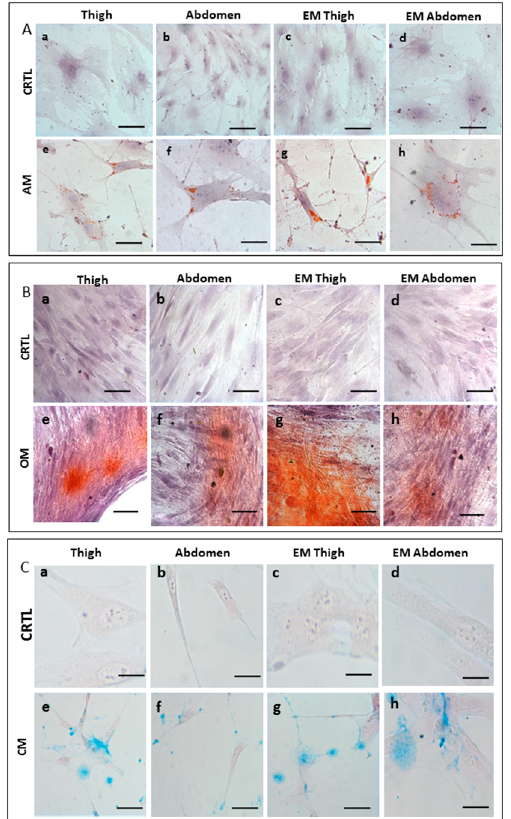
Figure 8. Cell differentiation assay. Multilineage differentiation potential of the ASCs from the thigh and abdomen after treatment with Rigenera ® compared to enzymatic methods (EM). ( A ) Cells were cultured with complete ASC medium (CRTL) ( a , b , c , scale bar 100 µm, d scale bar 50 µm) and adipogenic medium (AM) ( e , f , g scale bar 100 µm, h scale bar 50 µm). In the adipogenic medium, adipogenesis was indicated by the accumulation of neutral lipid vacuoles stained with Oil Red O, while the nucleus was stained with hematoxylin. ( B ) Cells were cultured with complete ASC medium (CRTL) ( a , b , c scale bar 100 µm, d scale bar 50 µm) and osteogenic medium (OM) ( e , f , g , h scale bar 100 µm). In osteogenic medium, osteogenesis was indicated by Alizarin Red S staining of extracellular matrix calcification, while the nucleus was stained with hematoxylin. ( C ) Cells were cultured with complete ASC medium (CRTL) ( a , c , d scale bar 50 µm, b scale bar 100 µm) and chondrogenic medium (CM) ( e , f , g scale bar 100 µm, h scale bar 50 µm). In chondrogenic medium, chondrogenesis was shown by the deposition of sulfated proteoglycan-rich matrix stained with Alcian blue, while the nucleus was stained with hematoxylin.